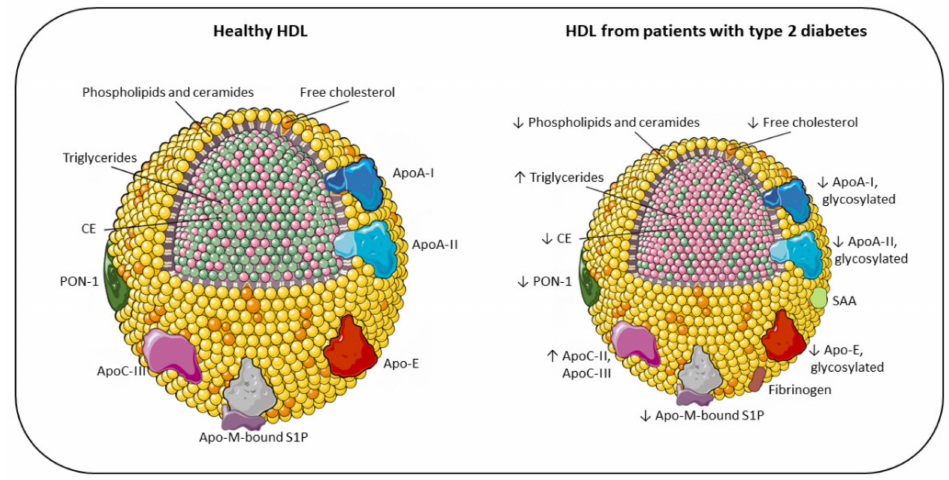
Figure 1. Main compositional differences between the HDL of healthy individuals and the HDL of patients with type 2 diabetes. Apo: apolipoprotein; CE: cholesteryl ester; PON-1: paraoxonase-1; S1P: sphingosine 1-phosphate; SAA: serum amyloid A; TG: triglyceride; ↓ : decreased; ↑ : increased. Schematic representation of the main changes in HDL composition due to